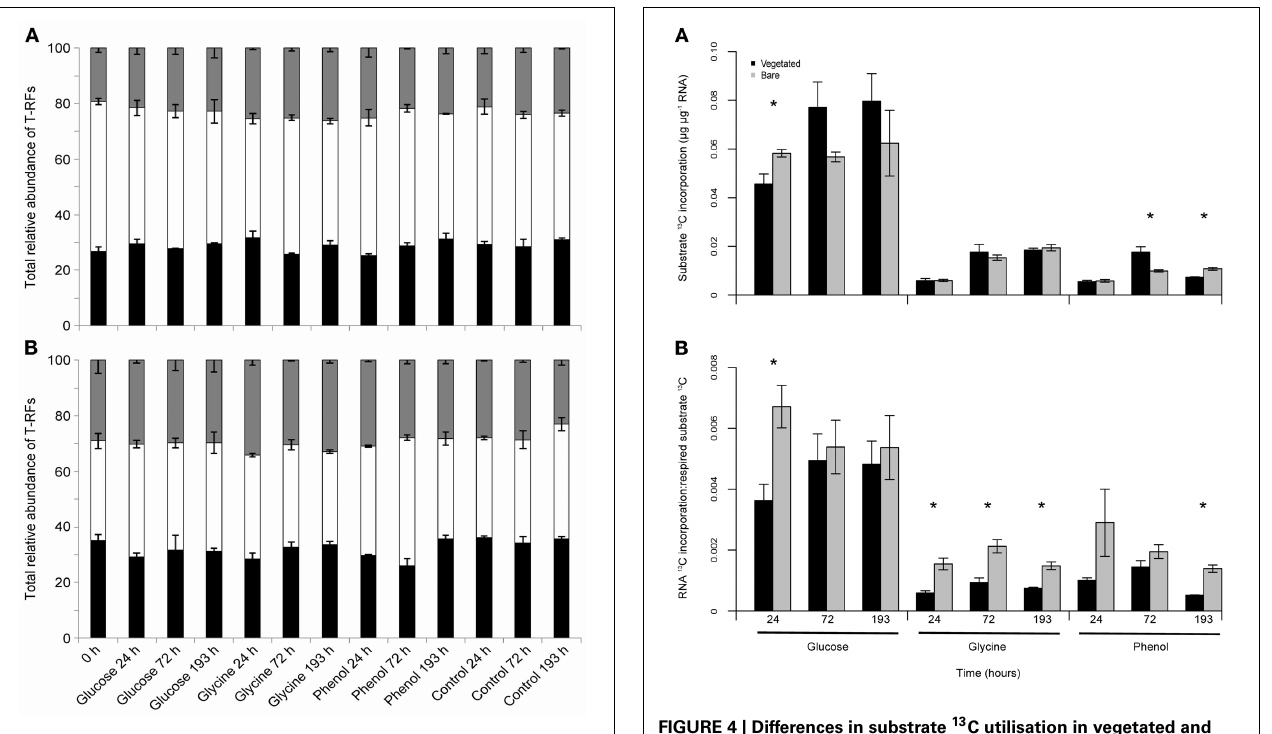
FIGURE 3 | Relative abundances of dominant bacterial taxa over time, following labile substrate additions. Totaled relative abundances of Acidobacteria T-RFs (black), Alphaproteobacteria T-RFs (white), and T-RFs representing all other taxa (gray) in vegetated (A) and bare (B) soils ( n = 3, error bars are SEM).